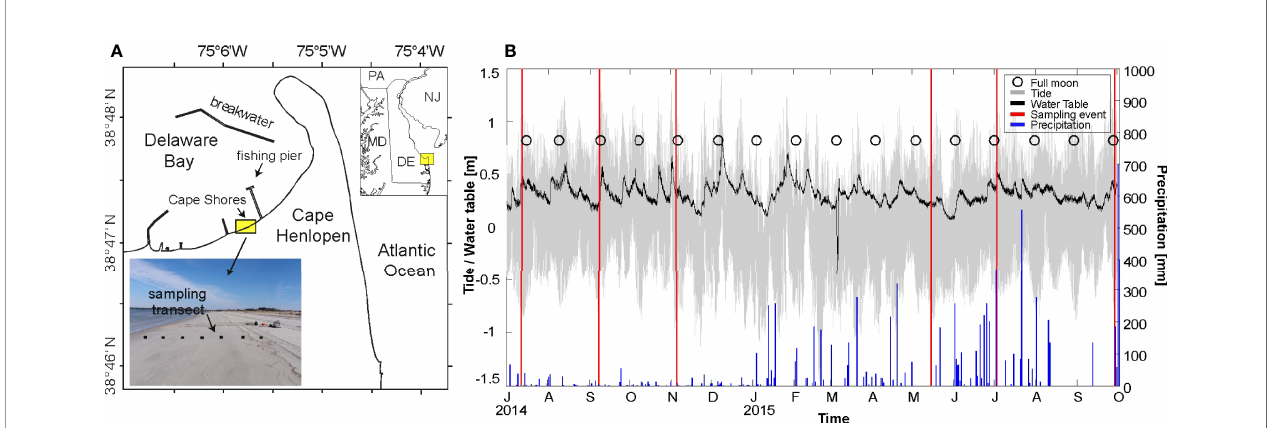
FIGURE 1 | (A) Field site location at Cape Shores near Cape Henlopen, DE, USA. Inset map shows the sampling transect that was perpendicular to shore. (B) Time series of tidal stage (gray), dune water table (black), and daily total precipitation (blue bars). Sampling events are indicated with a vertical red line. Tide levels were obtained from a nearby NOAA tidal station 8557830, and precipitation from NOAA Georgetown Sussex Country Airport